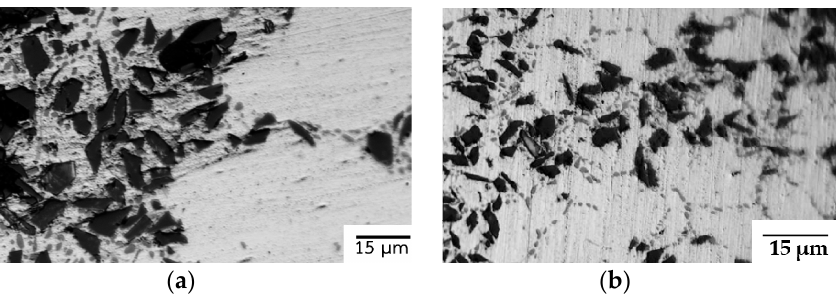
Figure 20. Micrographs showing modification of the Al-Si eutectic phase of ( a ) a thixoformed sample and ( b ) a rheo - die-casted sample .